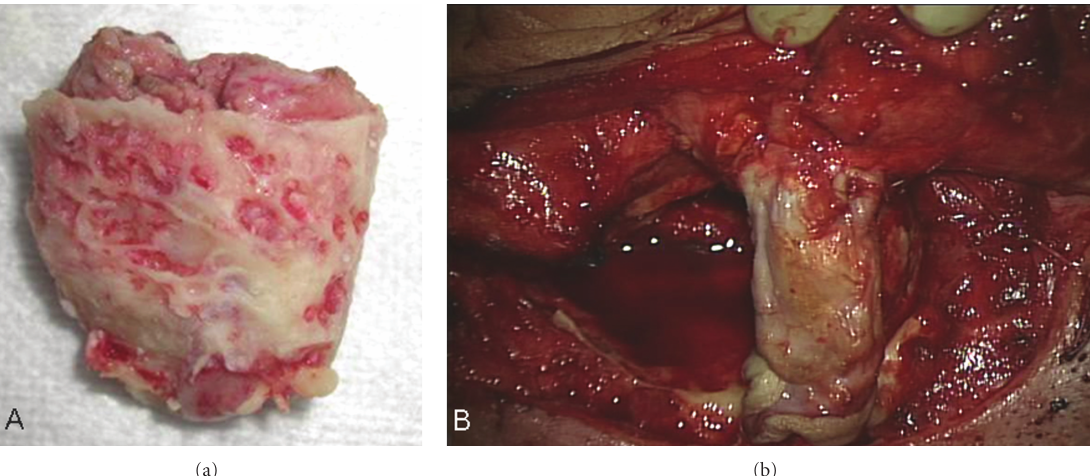
Figure 3: (a) Removal of the EAC with tumor. (b) The skin graft was rolled up and sutured with the inlet of the EAC and placed on the fascia as a substitute material for the tympanic membrane.